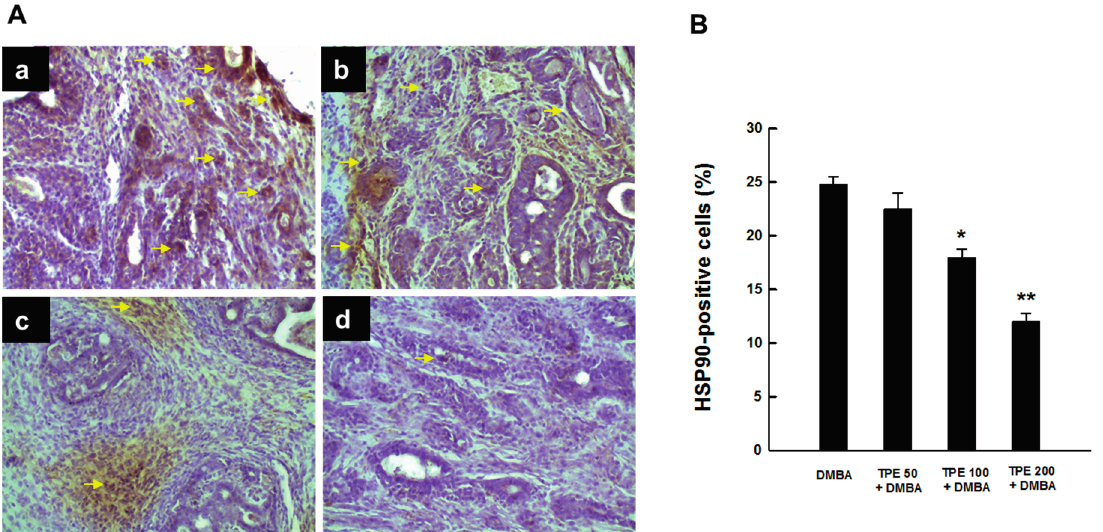
Figure 2. Expression of HSP90 during DMBA-initiated mammary gland tumorigenesis in rats in the presence or absence of TPE treatment. The animals were treated as indicated in legend to Figure 1. The mammary tumor sections were subjected to immunohistochemical analysis using anti-HSP90 antibody. ( A ) Immunohistochemical localization of HSP90-positive cells in tumor samples. Arrows indicate immunohistochemical staining of HSP90 (magnification: ×200). Various treatment groups are: ( a ) DMBA control; ( b ) TPE (50 mg/kg) plus DMBA; ( c ) TPE (100 mg/kg) plus DMBA; and ( d ) TPE (200 mg/kg) plus DMBA; ( B ) Quantitative analysis of HSP90-positive cells during DMBA mammary tumorigenesis in rats in the presence or absence of TPE treatment. Results are based on 1000 cells per animal and four animals per group. Each bar represents the mean ± SEM ( n = 4). * p < 0.01 and ** p < 0.001 compared to DMBA